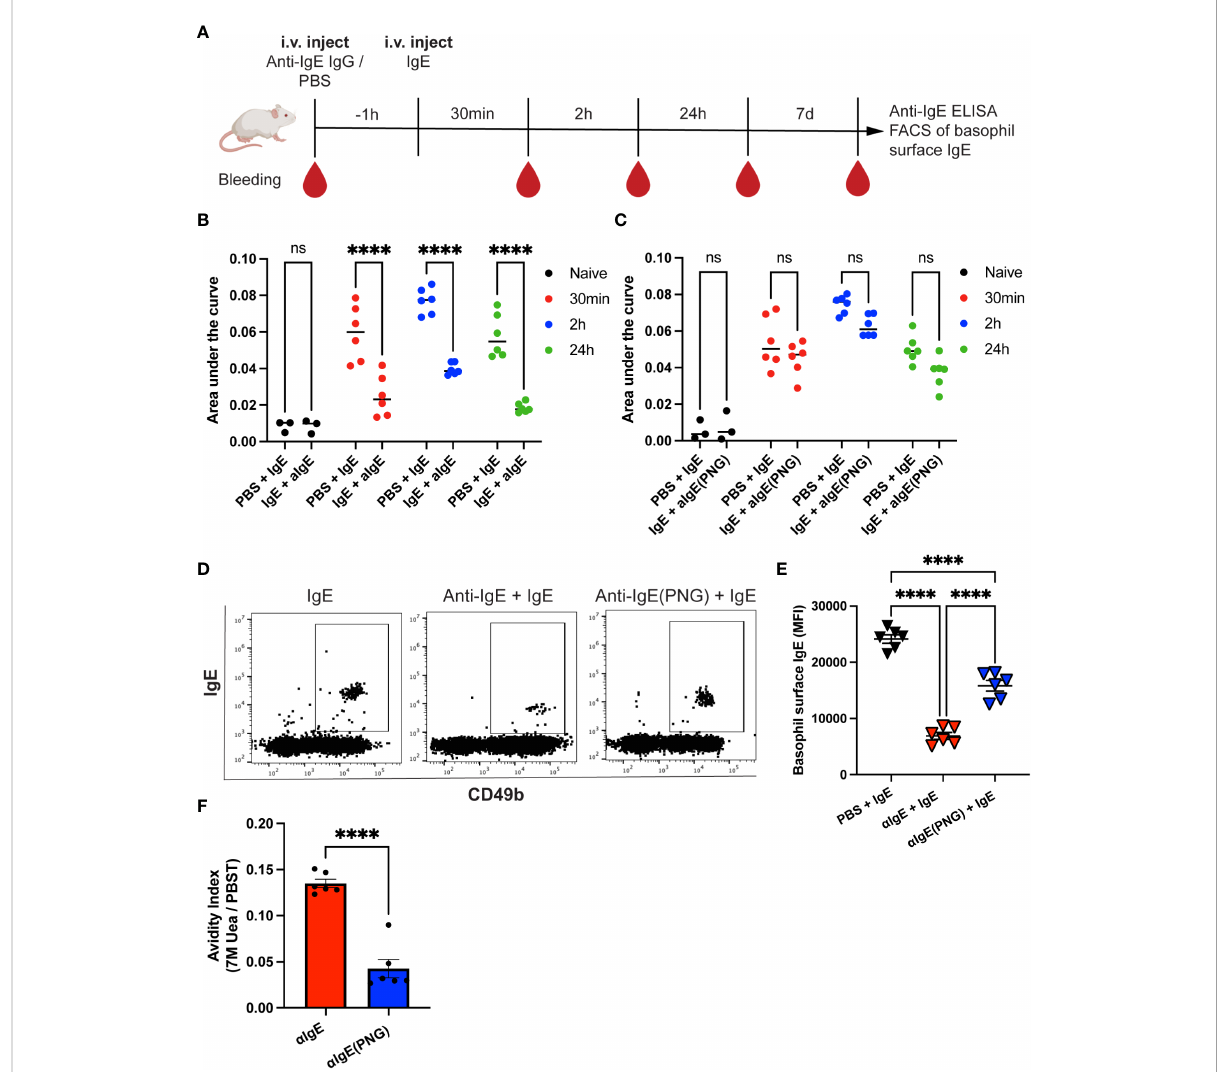
FIGURE 2 Anti-IgE IgG antibodies are more effective in lowering serum IgE levels than anti-IgE (PNG) IgG antibodies. Timetable with timepoints of injections, blood withdrawal, and experiments (A) . IgE serum levels were detected by ELISA and displayed as AUC at different time points after injection of IgE with or without passive immunization with anti-IgE IgG (B, C) . Shown are the results for IgE alone compared to IgE with anti-IgE IgG (B) and IgE alone compared to IgE with anti-IgE(PNG) IgG (C) . Representative FACS dot plot of basophils in mice immunized with IgE alone or with anti-IgE IgG or anti-IgE(PNG) (D) . Mean (± SEM) of IgE mean fl uorescence intensity on basophils from naive mice, mice injected with IgE, and mice injected with anti-IgE IgG and IgE (E) . Avidity index of anti-IgE IgG and anti-IgE(PNG) to IgE (F) . Statistical analysis (mean ± SEM) using two-way ANOVA (B, C) , one-way ANOVA (E) , and unpaired students t-test (F) . n = 6 from two independent experiments. The signs for statistical signi fi cance are ns = not signi fi cant and p ≤ 0.0001